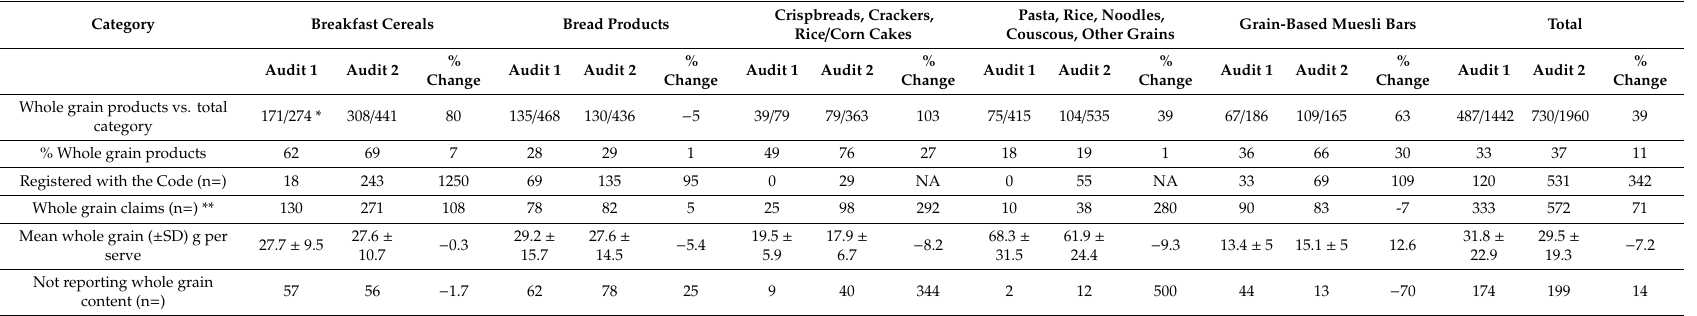
Table 4. Changes in whole grain products, registered product claims, mean whole grain content, and proportion not reporting whole grain content 2013–2019, based on Grains & Legumes Nutrition Council audit